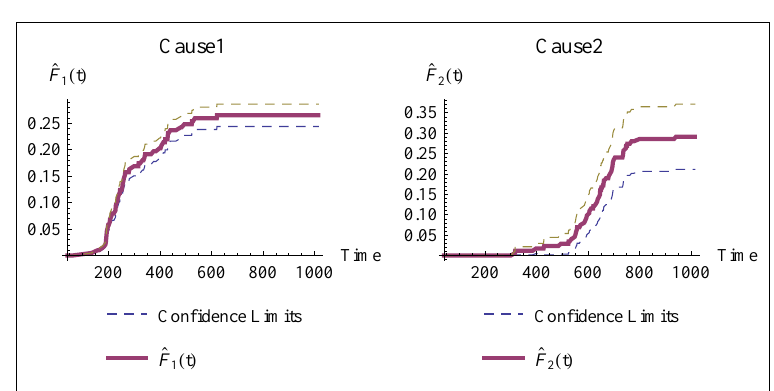
Figure 1 { Plot of estimate of F j ( t ); j = 1 , 2 for mice mortality data a definite analysis of the data. The first data give the survival times of mice, kept in a conventional germ-free environment, all of which were exposed to a fixed dose of radiation at an age of 5 to 6 weeks (Hoel (1972)). There are 3 causes of death viz thymic lymphoma (cause 1), reticulam cell sacroma (cause 2), and other causes (cause 3). This data were analysed by different researchers in various contexts (See Lawless (2003)). We treat other failures due to cause 3 as left censored observations. The estimates of H j ( t ) and F j ( t ) j = 1 , 2, are computed at different time points. For j = 1 , 2 the estimates of H j ( t ) and its standard error (written in parenthesis) are given in Table 5. Plots of ˆ F j ( t ) , j = 1 , 2 along with 95% confidence limits are given in Figure 1. From Figure 1 it can be seen that ˆ F ˆ F 1 ( t ) predominates over 2 ( t ), which means that most of the initial failures are due to cause